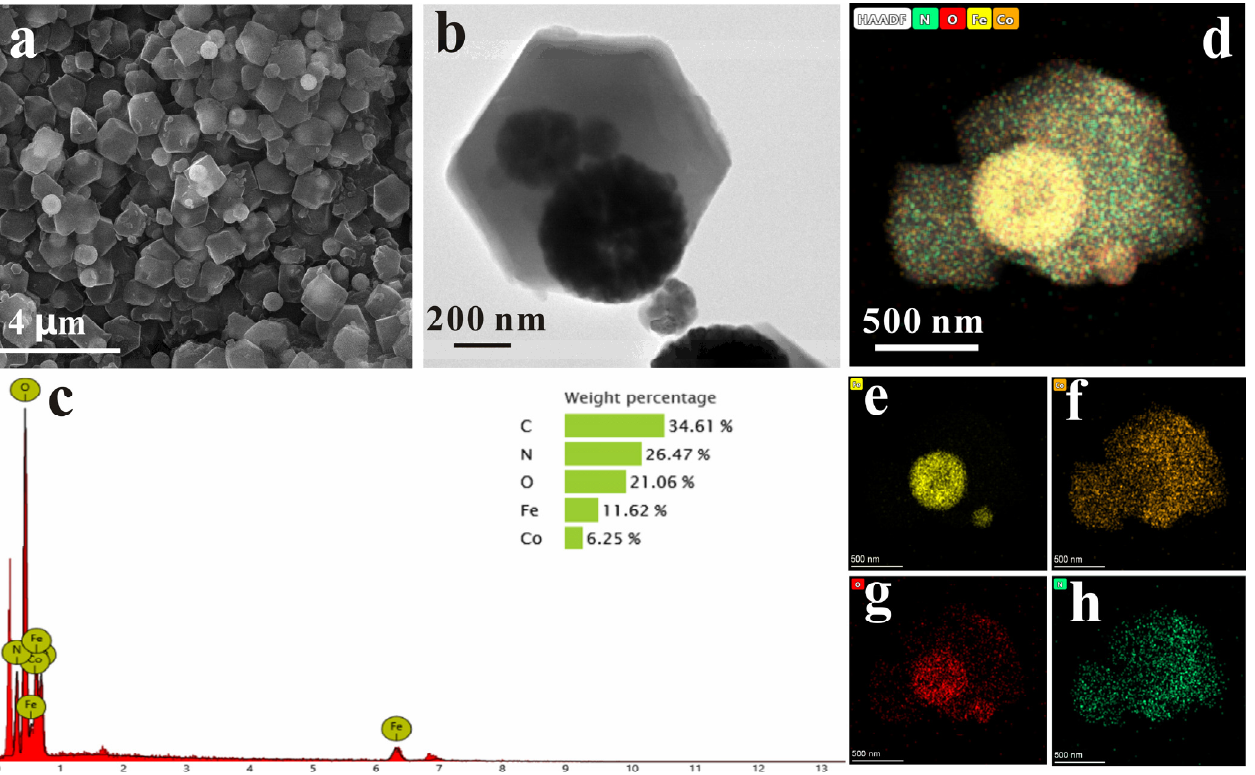
Figure 1. The SEM ( a ) and TEM images ( b ) of Fe 3 O 4 @ZIF − 67. ( c ) The energy-dispersive X-ray spec-